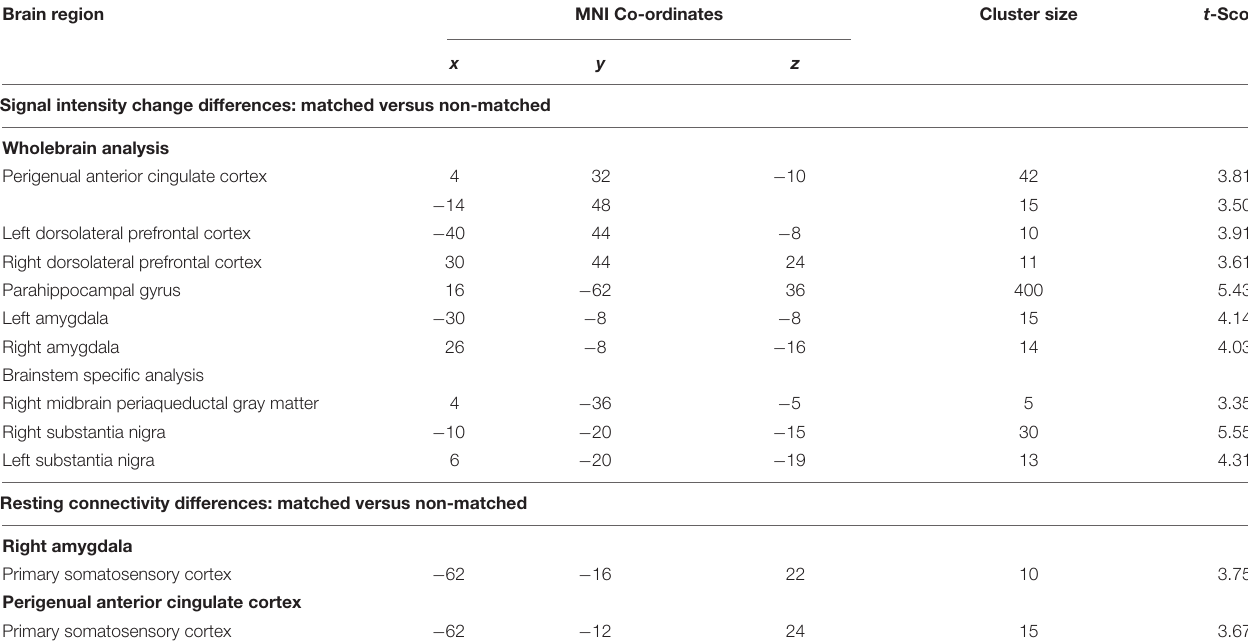
TABLE 1 | Montreal Neurological Institute (MNI) coordinates, cluster size, and t -score for regions in which signal intensity increases or connectivity were significantly different during matched versus non-matched trials. Brain region MNI